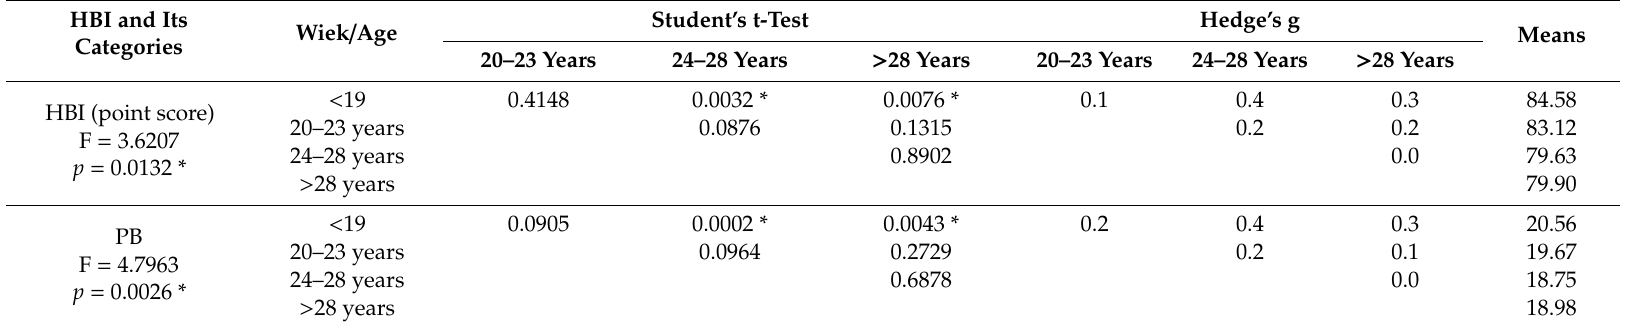
Table 5. Health behaviors of people who practice CS and MA, in relation to age (F-test, Student’s t-test, Hedge’s g). HBI and